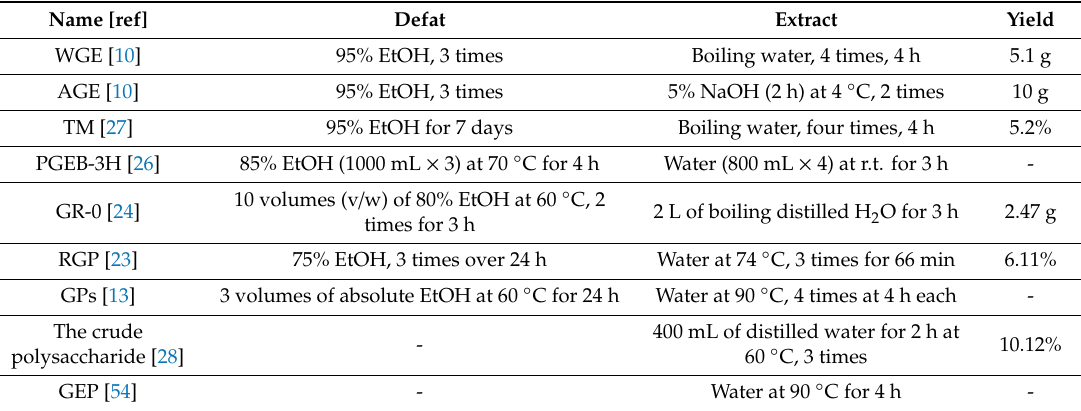
Table 1. The extraction methods of several polysaccharides from G. elata